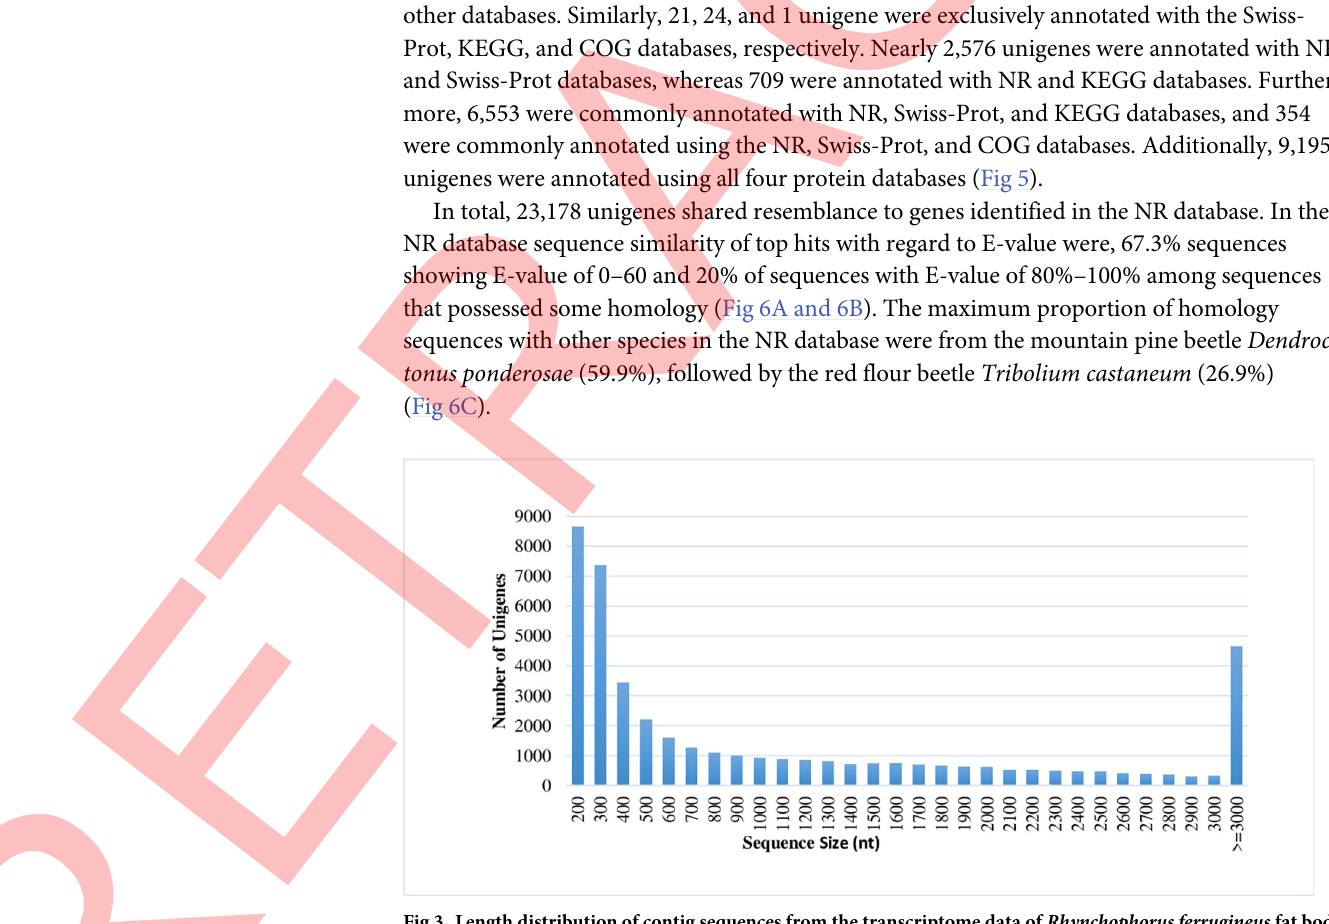
Fig 3. Length distribution of contig sequences from the transcriptome data of Rhynchophorus ferrugineus fat body tissues. Nucleotide sequence size (nt) and number of contigs are shown on the X- and Y-axes, respectively.